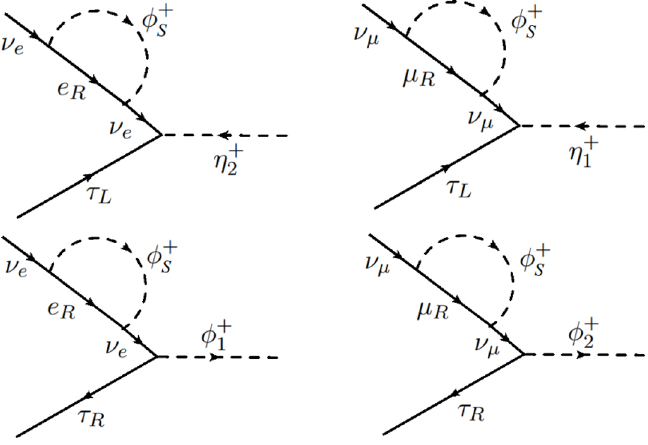
Figure 6 . Feynman diagrams generating coupling shifts in the SU(2) H model.